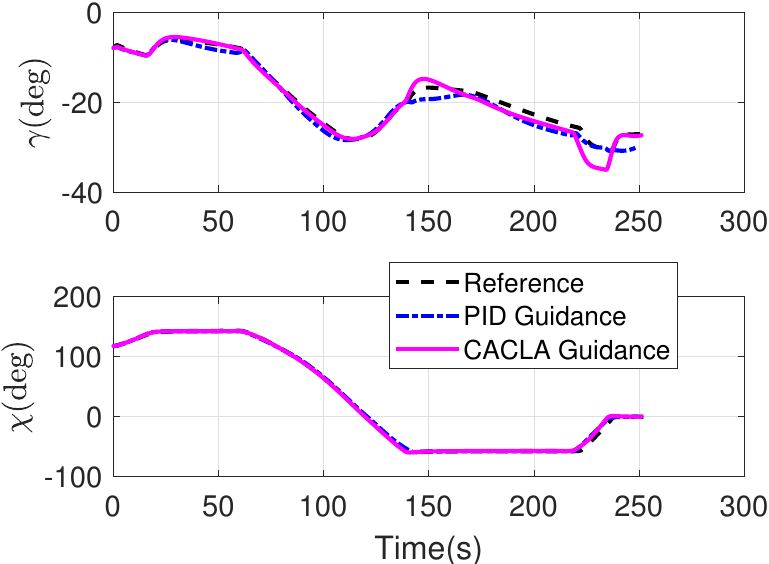
Figure 9. Flight path angle and heading angle profiles with respect to time in comparison